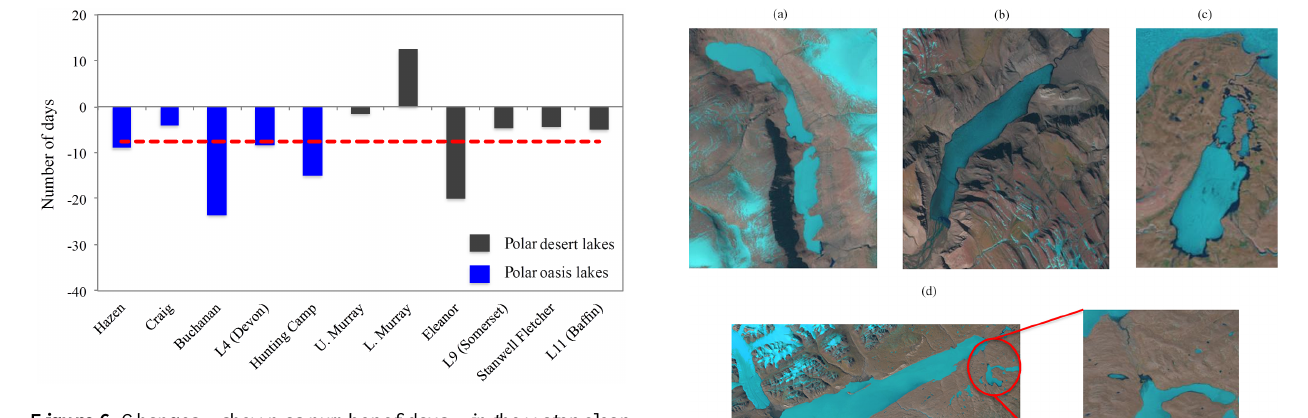
Figure 6. Changes – shown as number of days – in the water-clear- of-ice date of investigated lakes in the central and eastern Canadian High Arctic (1997–2011). Number of days change is reported rel- ative to the 1997–2011 mean water-clear-of-ice day derived from spaceborne observations during this period. Lakes in polar-oasis en- vironments are shown as blue bars and lakes in polar-desert environ- ments are shown as grey bars. The red line indicates the 1997–2011 mean number of days change for water that is clear of ice.